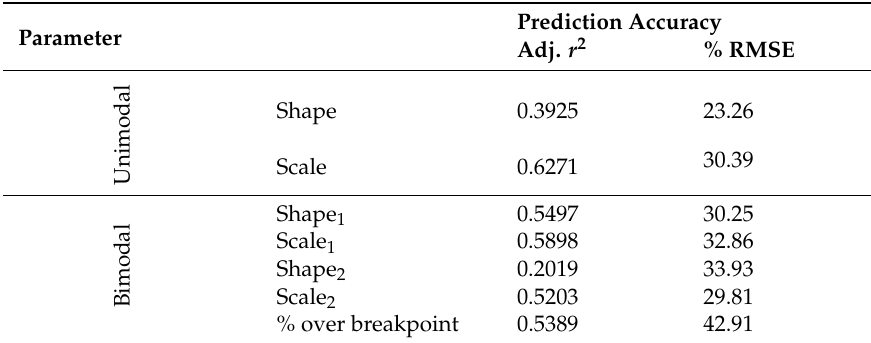
Table 6. Prediction accuracy of SSD parameters for unimodal ( n = 48) and bimodal ( n = 23) plots as differentiated by ALS.